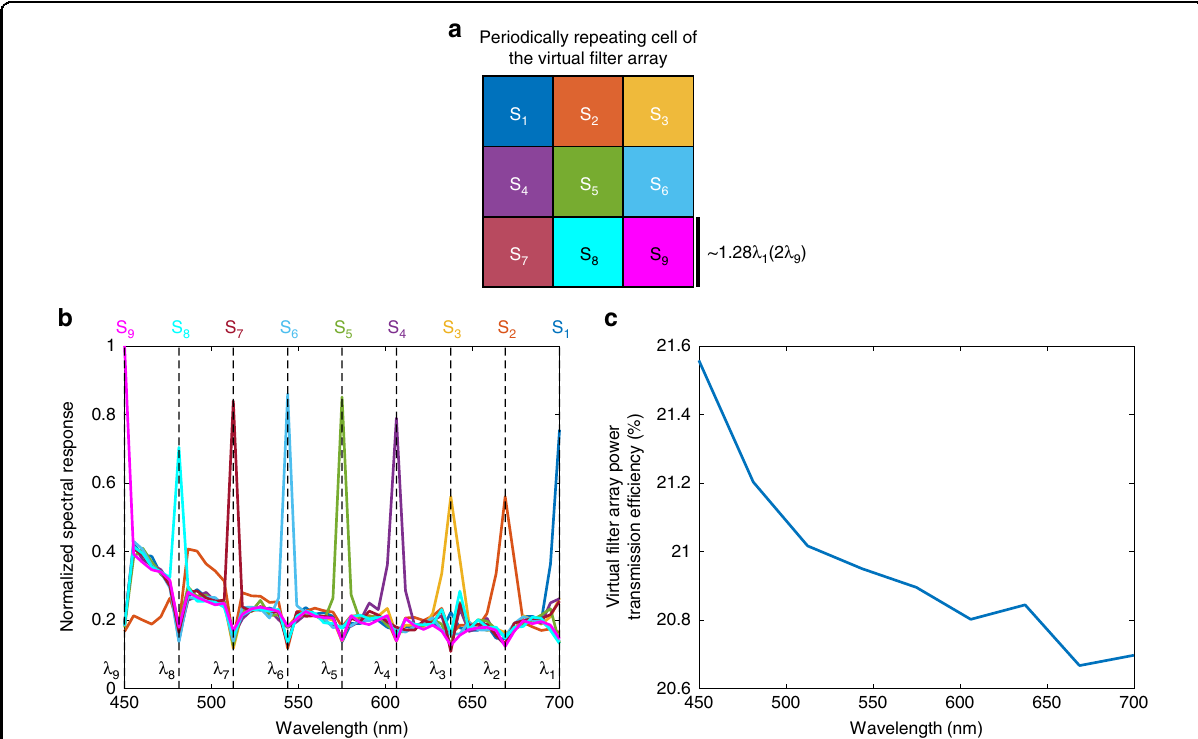
Fig. 3 Spectral responsivity and power ef fi ciency achieved by the diffractive multispectral imager shown in Fig. 2 ð N B ¼ 9 Þ . a The virtual spectral fi lter array periodically repeats at the output fi eld of view of the diffractive network. The colored labels, S i , i ¼ 1 ; 2 ; 3 ; ¼ ; 9, denote the virtual pixels assigned to the wavelength λ i . b Average normalized spectral response of the virtual fi lter array. c The wavelength-dependent transmission power ef fi ciency of the virtual fi lter array created by the diffractive optical